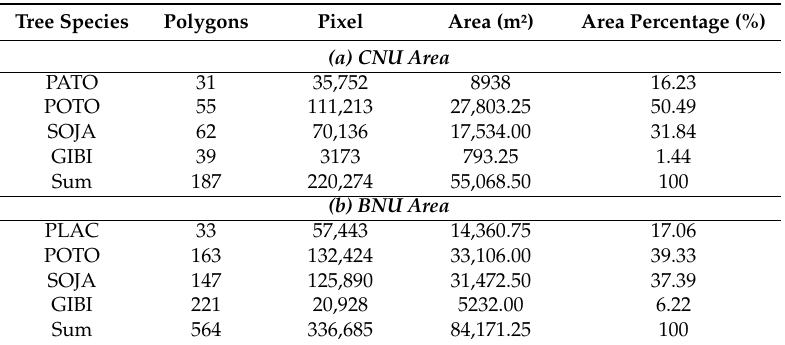
Table 2. Distribution and percentage of samples delineated in both areas.